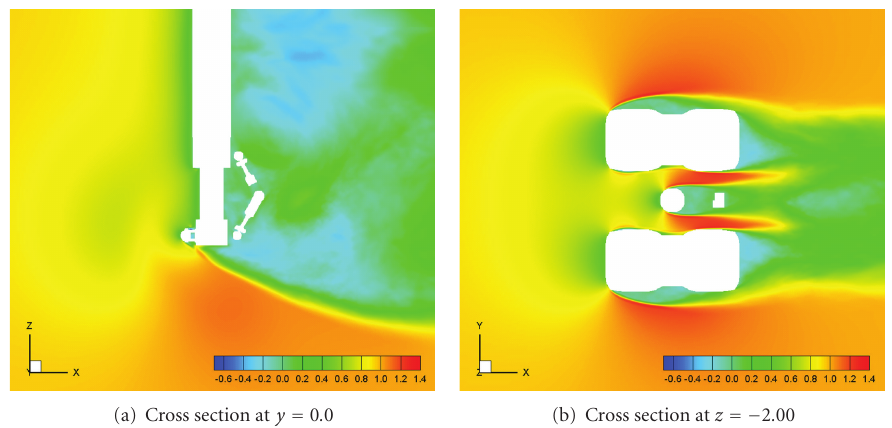
Figure 8: Computed mean velocity component in the freestream direction.